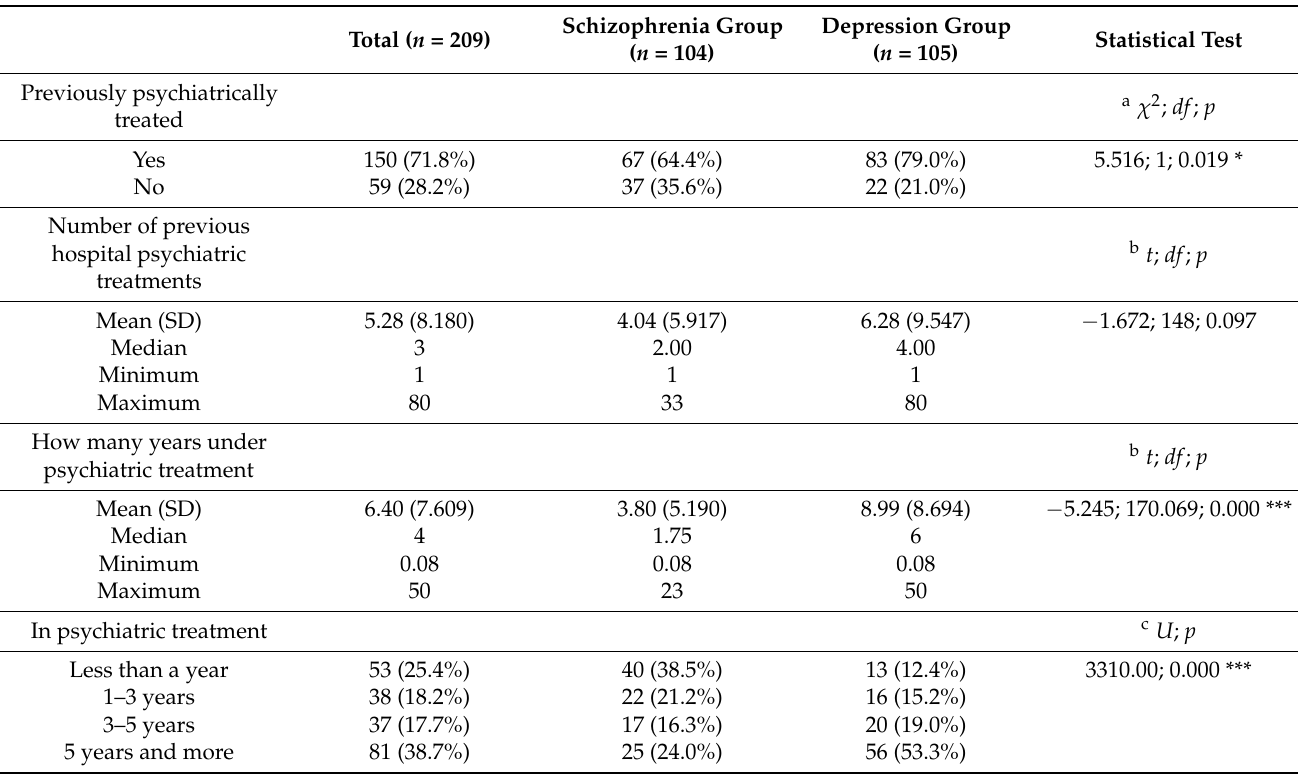
Table 4. Psychiatric history of the